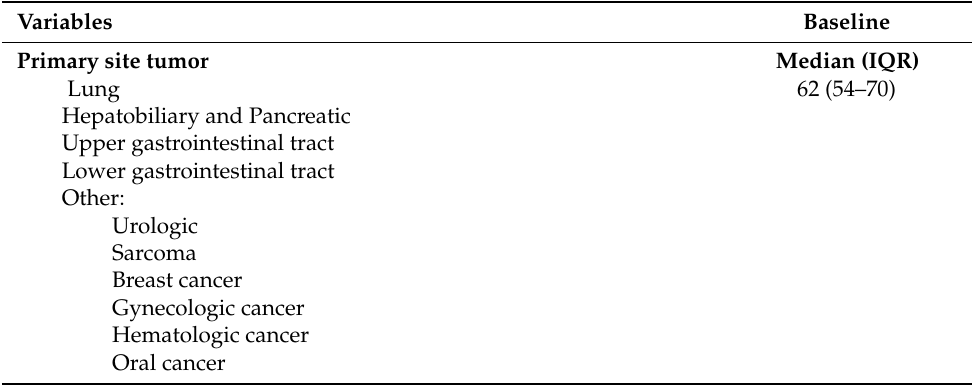
Table 1. Baseline clinical